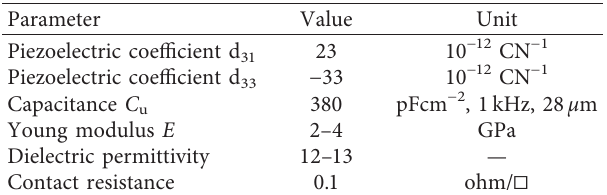
Table 1: PVDF foils parameters important for the proposed